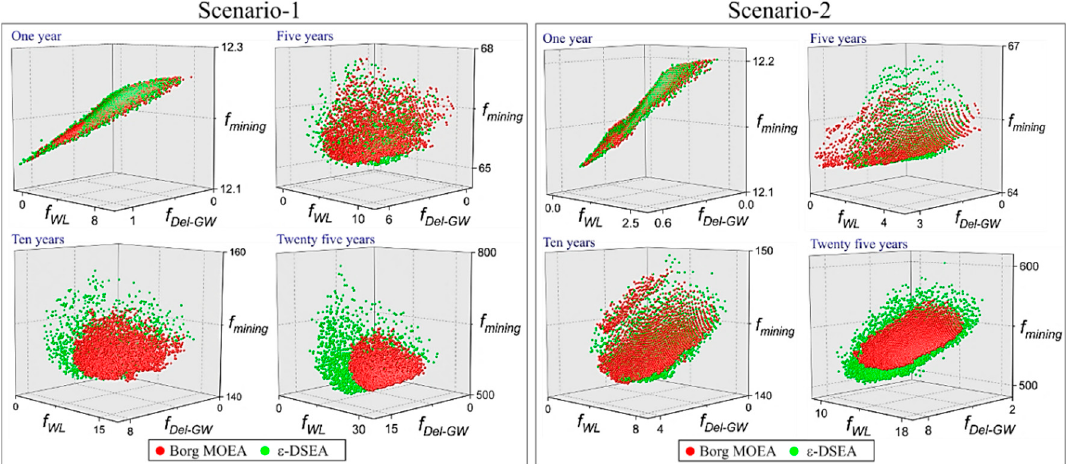
Figure 5. Optimum solution Pareto-front for both irrigation alternative scenarios using both algorithms. f Del-GW , f WL , and f mining refer to groundwater delivery, water losses, and mining objectives functions, respectively.